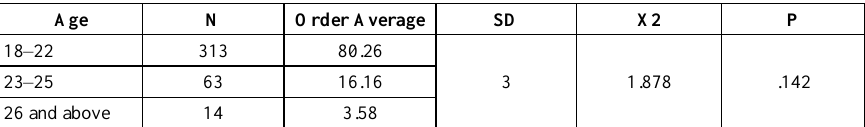
Table 7. Distance education status by